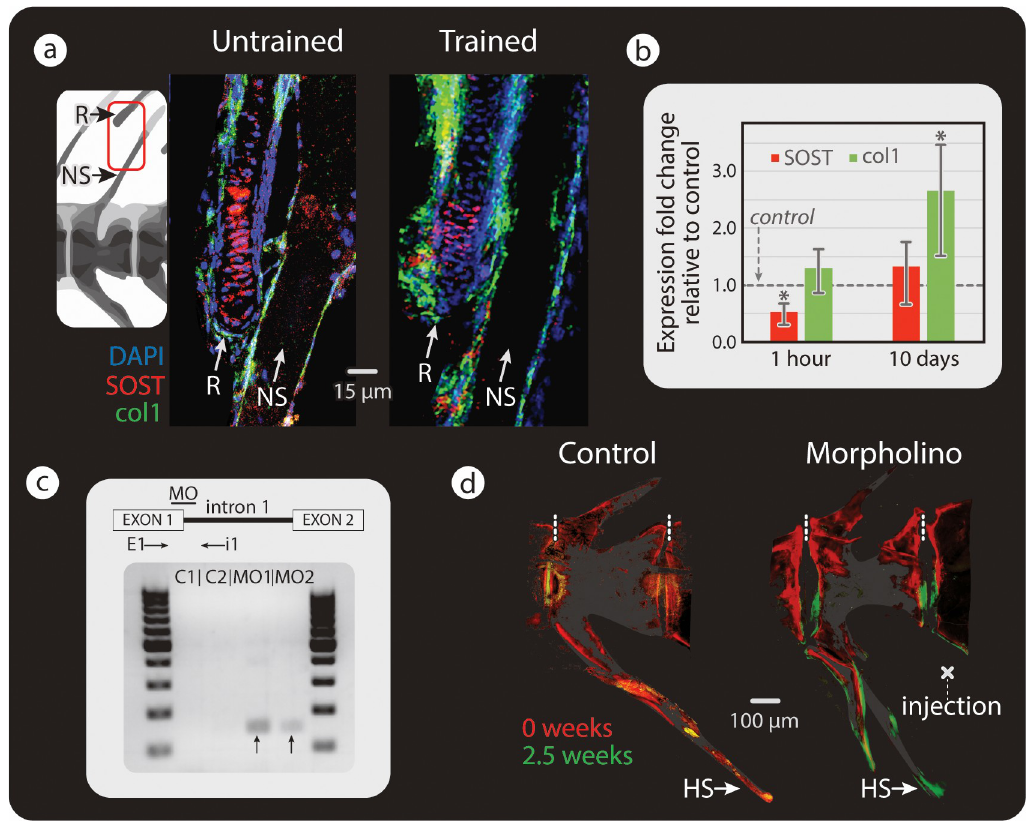
Fig 6. Mechanical load and SOST down-regulation cause increased bone formation. (a) Double fluorescent ISH, showing SOST (red) and Col1a1 (green) in the spine and adjacent R of untrained (left) and trained (right) medaka ( n = 3 for each group). In trained medaka, SOST expression appears down-regulated (as inferred from changes in staining intensity), while osteoblast recruitment is increased. (b) RT-qPCR results of SOST and Col1a1 expression after 1 hour ( SOST : swim trained n = 5, untrained n = 7 and Col1a1 : swim trained n = 4, untrained n = 6) and 10 days of swim training of medaka (for both SOST and Col1a1 : swim trained n = 5, untrained n = 4), (compared to levels in untrained medaka: gray, horizontal “control” line). Results were normalized to the rlp-7 housekeeping gene. Asterisks indicate a significant difference ( p < 0.05) between trained and untrained (control) fish. Original raw data can be found in S1 Data. (c) Top: illustration of splice site blocking MO-binding site and primers used to detect morphant transcripts (E1, i1). Bottom: RT-PCR of medaka injected with standard control (C1, C2) and with SOST MO (MO1, MO2). Bands indicative of SOST splice blocking appeared in SOST MO-injected samples (black arrows) and not in the standard control samples. (d) Bone-formation dynamics marked by fluorochromes (red: alizarin red, injected at t = 0 weeks; green: calcein green, injected at t = 2.5 weeks) in vertebra of medaka injected with standard control MO (left) and SOST MO (right). Dashed, vertical white lines mark the border between vertebrae. NSs are cropped in fluorescence images in (d). Col1a1 , collagen type I alpha 1; E1, exon-spanning forward primer; HS, hemal spine; ISH, in situ hybridization; i1, intron- spanning reverse primer; MO, vivo-morpholino; NS, neural spine; PCR, polymerase chain reaction; R, radial; RT-PCR, reverse transcription PCR; RT-qPCR, real-time quantitative